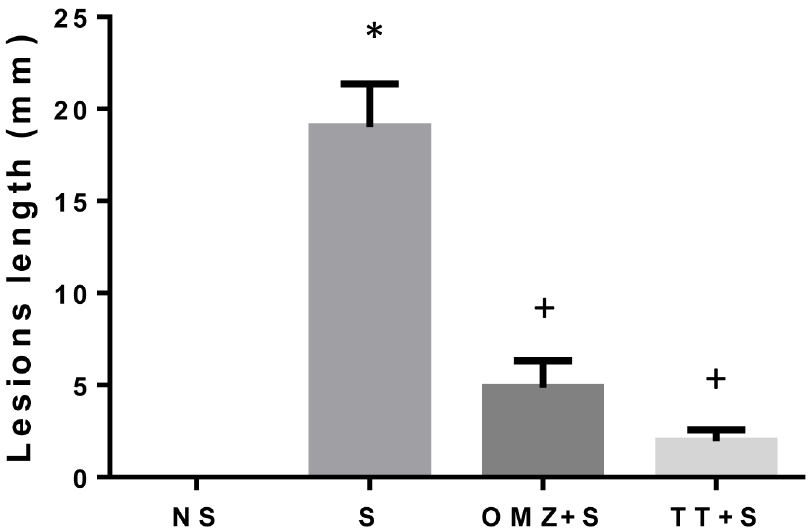
doi:10.1371/journal.pone.0139348.g001